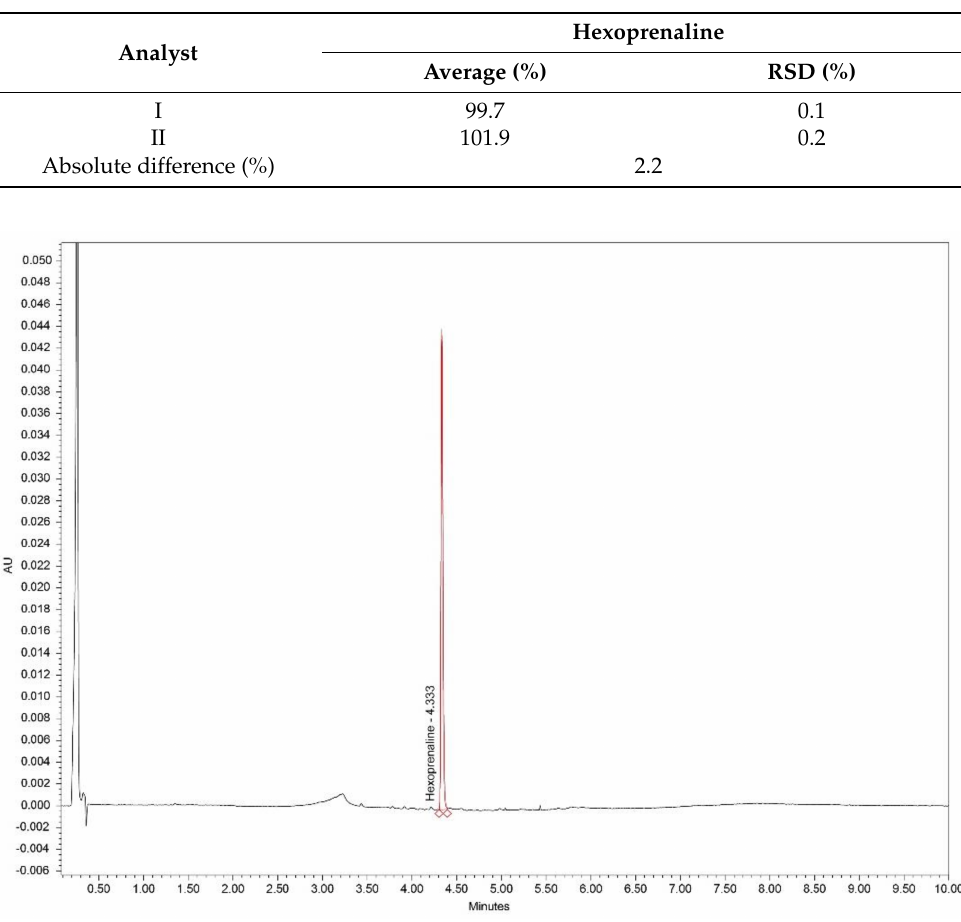
Figure 9. Chromatogram of hexoprenaline in Gynipral sample at 280